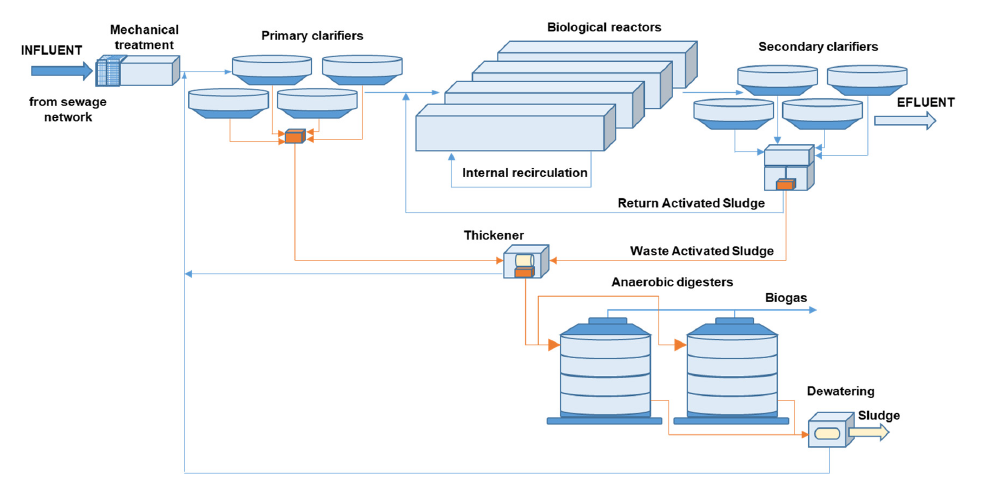
Figure 1. The general scheme of the wastewater treatment plant of Galati city.